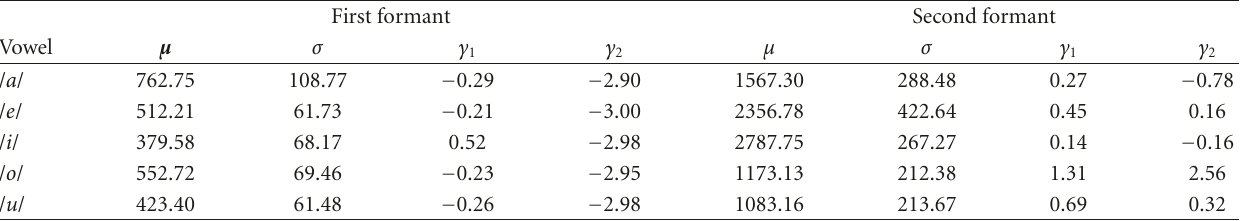
Table 4: Mean ( μ ), standard desviation ( σ ), skewness ( γ corpus.